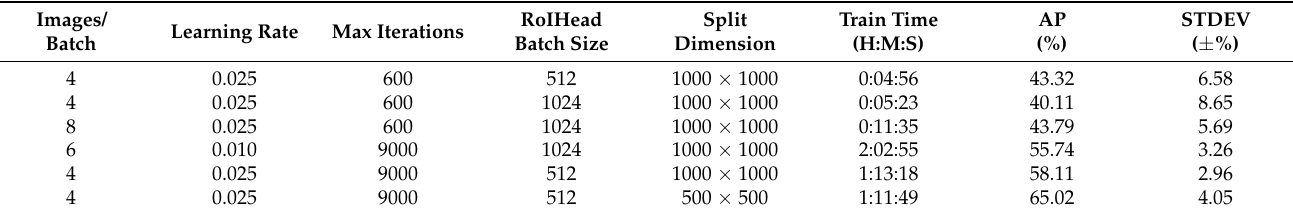
Table 5. Results for object detection task on